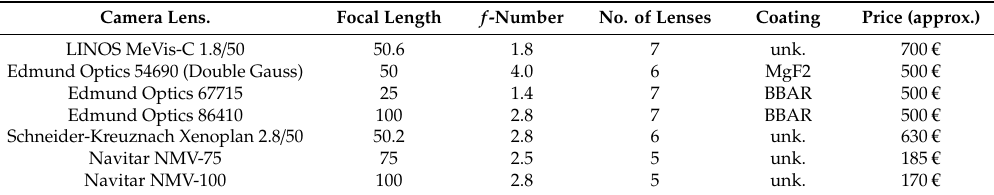
Table 2. Parameters of the investigated camera